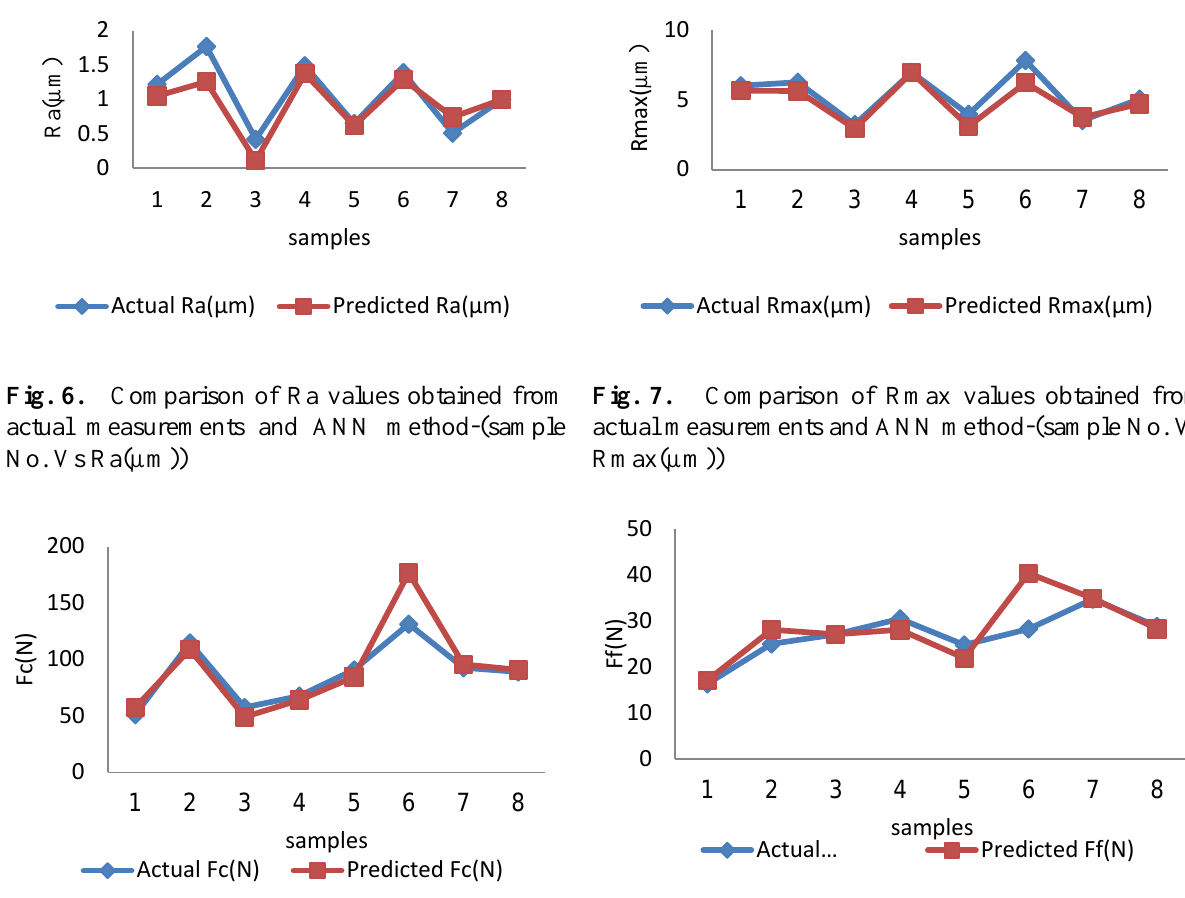
Fig. 8. Comparison of Fc values obtained from actual measurements and ANN method-(sample No. Vs Fc(N))